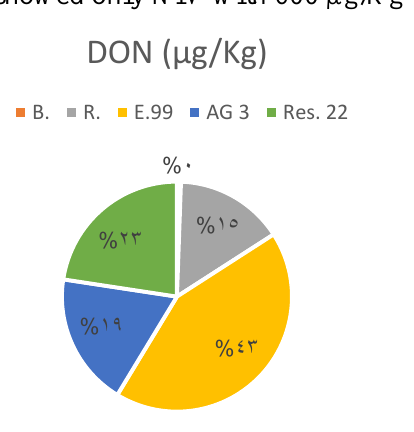
Figure, 6: illustrated the cultivar types that showed concentration rates of mycotoxins (DON) as percentage in the 17 selected wheat fields in the south of Iraq/ Basra